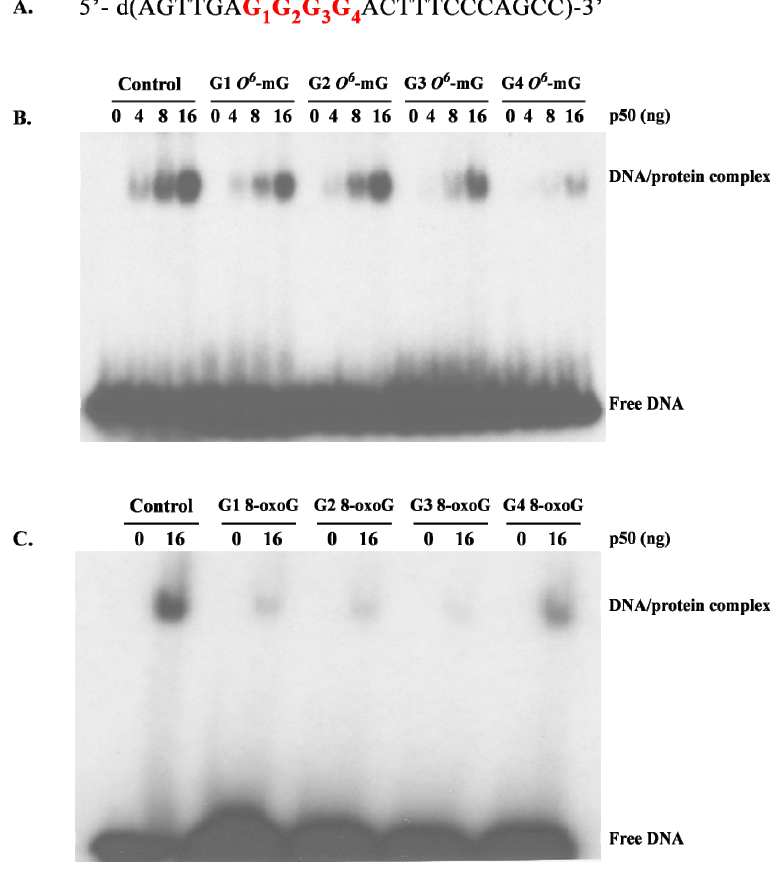
Figure 10. Autoradiograms showing the gel shift induced by binding of the p50 subunit of NF-kB to its DNA recognition sequence containing a DNA lesion. ( A ) Recognition sequence for the p50 subunit of NF-kB. Four oligonucleotides, each containing a guanine (G) or either an O 6 -mG ( B ) or 8-oxoG ( C ) located in the consensus sequence of the p50 subunit, were incubated with different concentrations of purified p50, electrophoresed and the autoradiograms examined for bands by chemiluminescence. The concentration dependence of the DNA-p50 complex was demonstrated by the addition of 0, 4, 8, or 16 ng of purified p50 in the reaction mixture. This suggests that binding of the transcription factor (NF-kB) to its cognate DNA recognition sequence is altered both by the nature and the specific location of the DNA lesion (images derived from unpublished data).